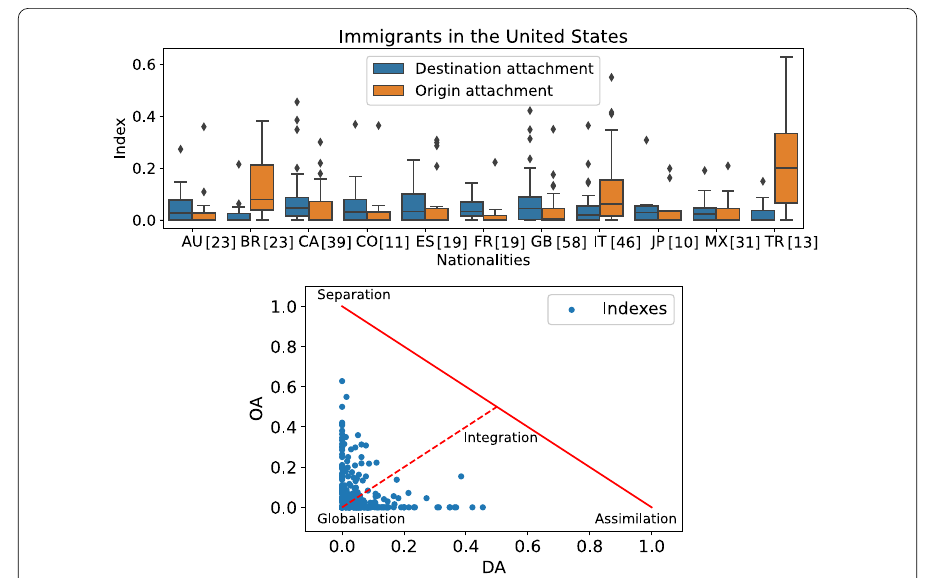
Figure 7 Top: Box plots for the DA and OA index of immigrants in the United States. Bottom: Scatter plot of OA vs. DA indicating approximate integration types for immigrants in the US